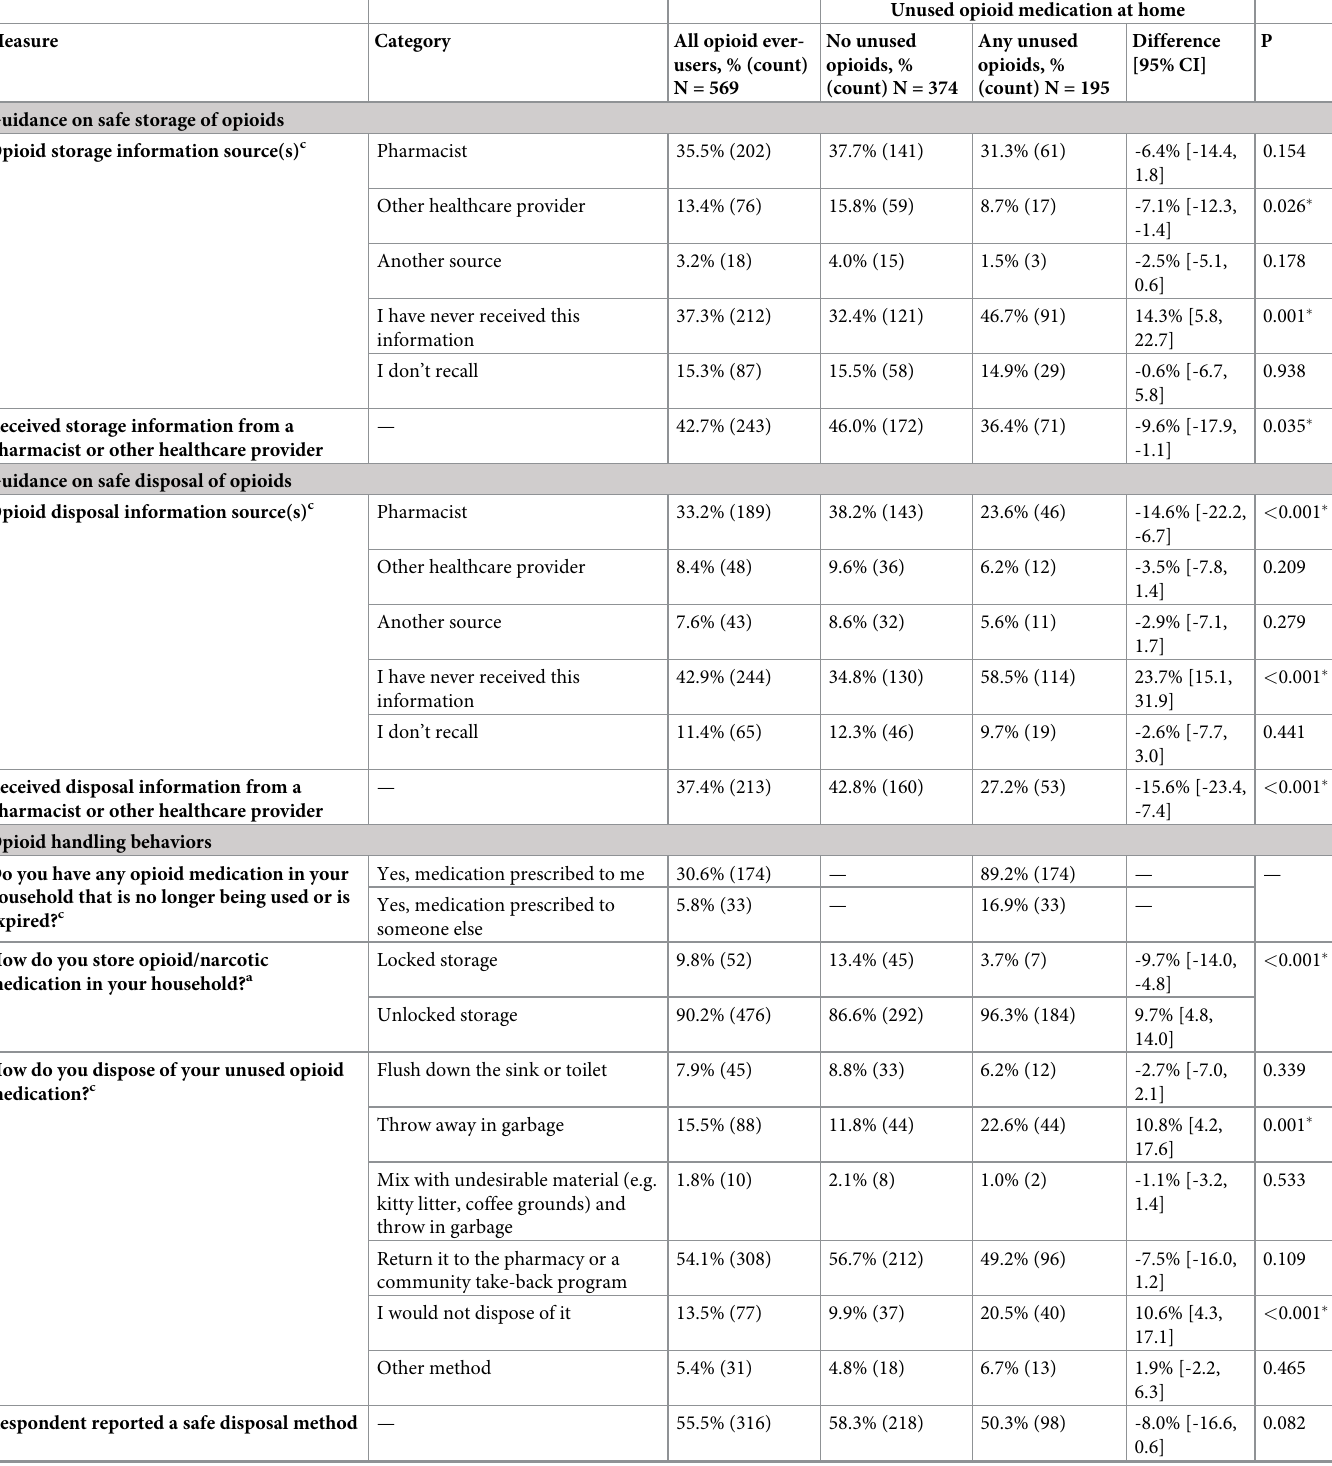
Table 2. Opioid handling information sources and behaviours, overall and by presence of unused opioids at